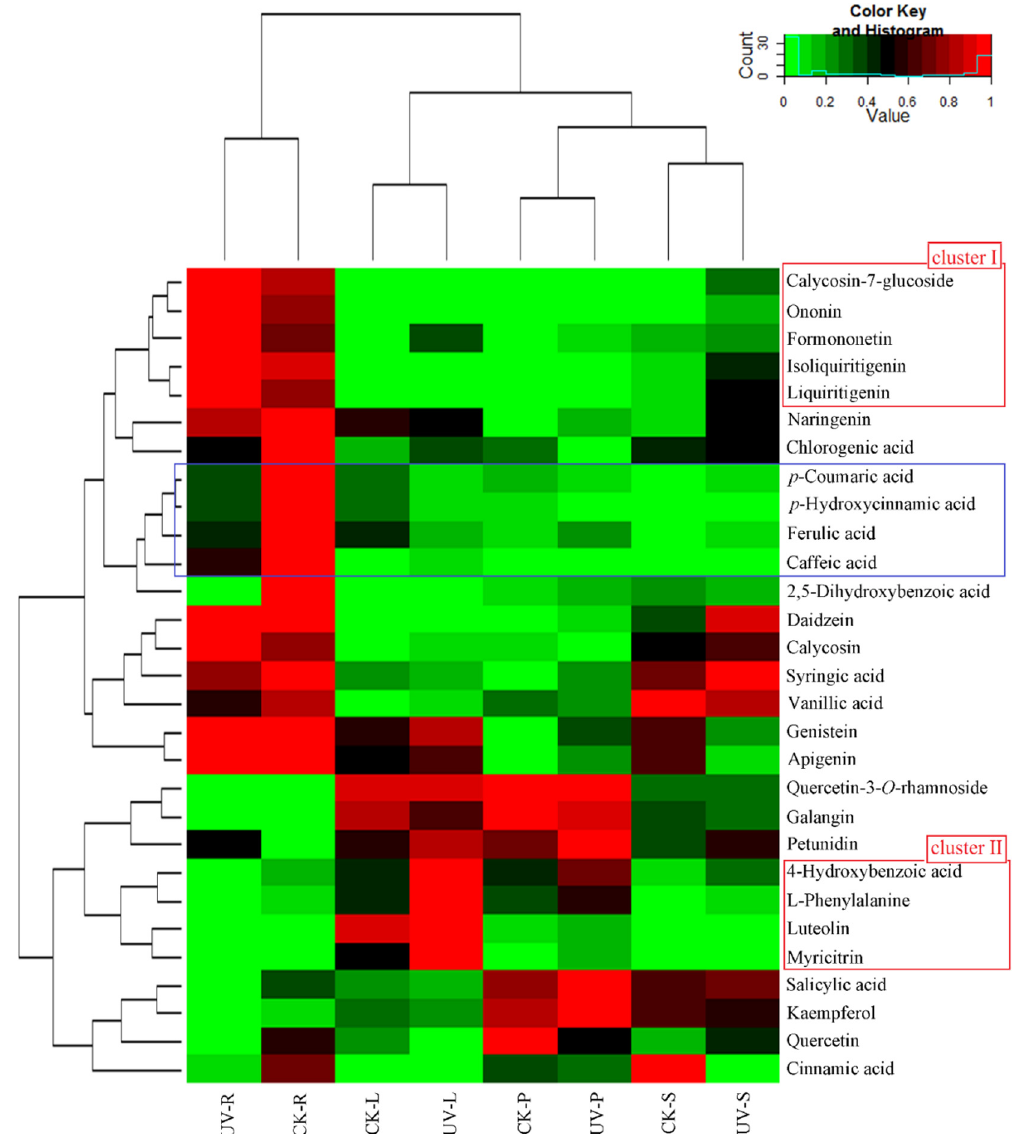
Figure 3. Distribution of potential biomarkers in specific tissues from the control and UV-B treatment groups. Heat map visualization of the relative differences of potential biomarkers in the different samples. The data of the content value of each compound were normalized to complete the linkage hierarchical clustering. Each tissue type is visualized in a single column, and each metabolite is represented by a single row: CK-R, CK-S, CK-L, and CK-P correspond to roots, stems, leaves, and petioles of the control group; UV-R, UV-S, UV-L, and UV-P correspond to roots, stems, leaves, and petioles from the UV-B-treated group. Red indicates high abundance of compounds, whereas green indicates low abundance (color key scale above heat map).